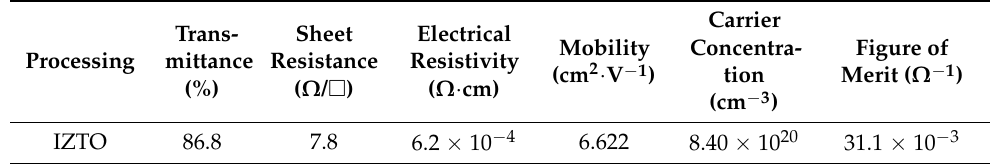
Figure 3. The optical transmittance spectra of the different TCO films. Table 3. The comparison of Hall measurement results, transmittance, and Φ TC values of the different TCO films.